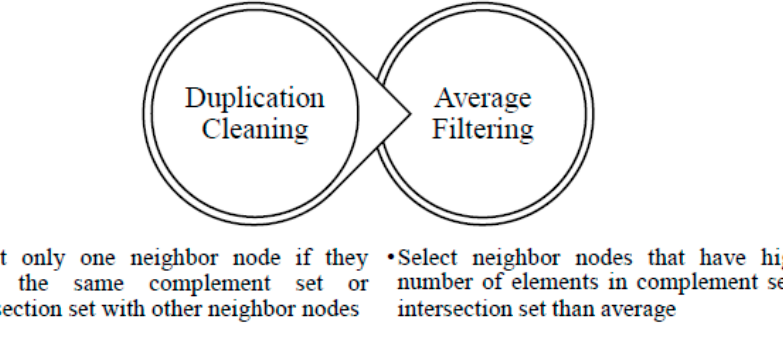
Figure 4. Two main steps in IACS method to remove the redundant neighboring node.